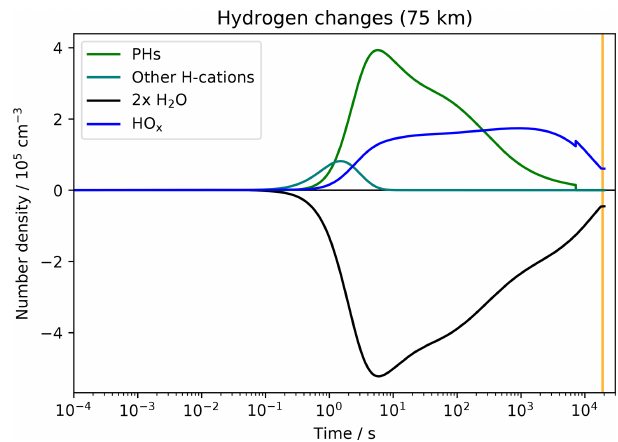
Figure 7. Evolution of the modelled amount of hydrogen atoms contained in selected species at 75km altitude for RUN1. Shown are the differences between the sprite model run and the model run without electric fields applied. PHs denotes all hydrogen atoms in proton hydrates. The teal solid line depicts all hydrogen atoms in positive ions except for proton hydrates. The vertical orange line indicates the time of sunrise.